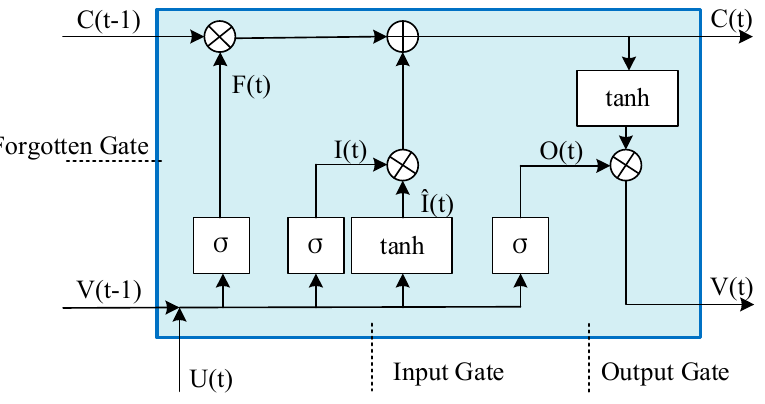
Figure 3. LSTM network structure.